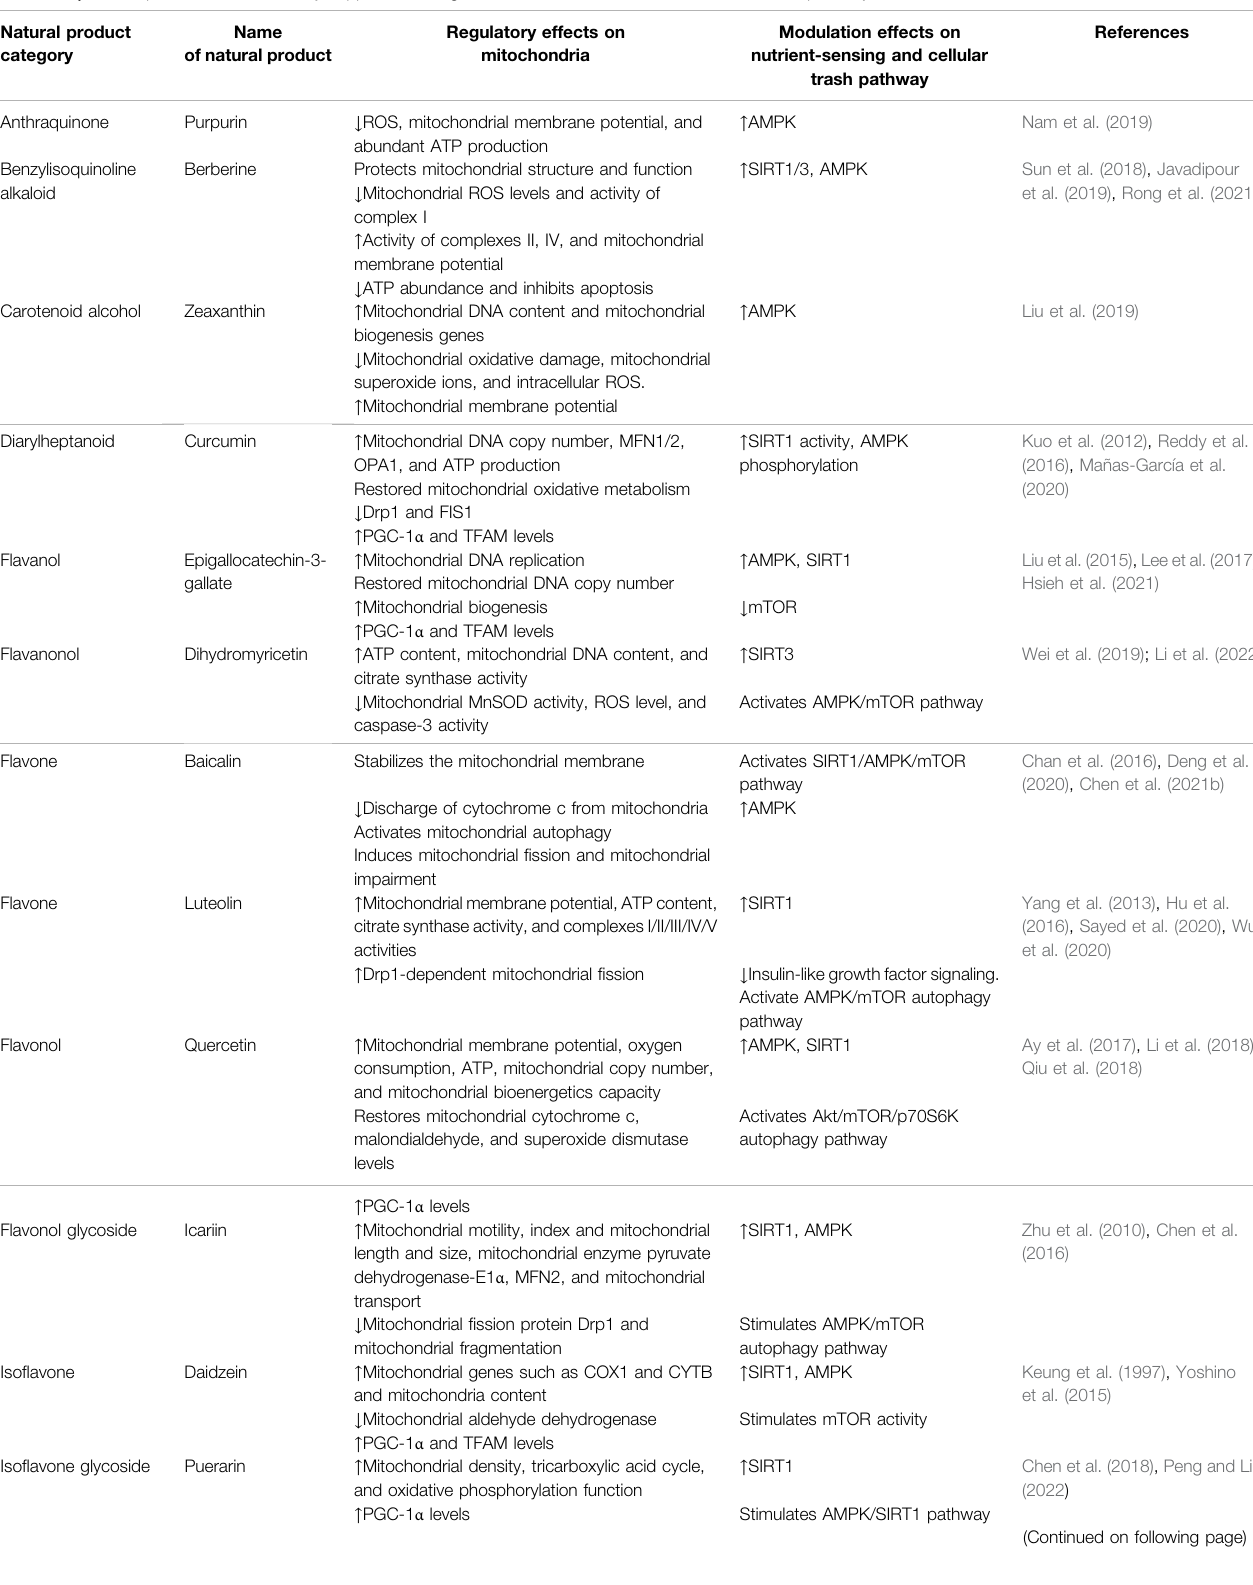
TABLE 1 | Natural products and/or dietary supplements target mitochondria and metabolic mediators and pathways. Natural product